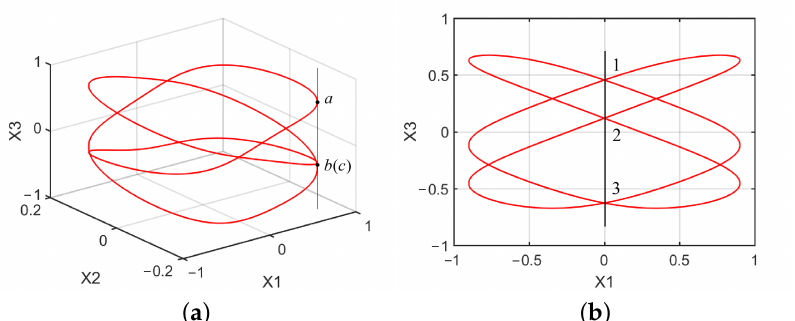
Figure 13. Periodic-3 motion of σ 1 = 0.67, σ 2 = 0.5716: ( a ) ( x 1 , x 2 , x 3 ) space; ( b ) ( x 1 , x 3 )